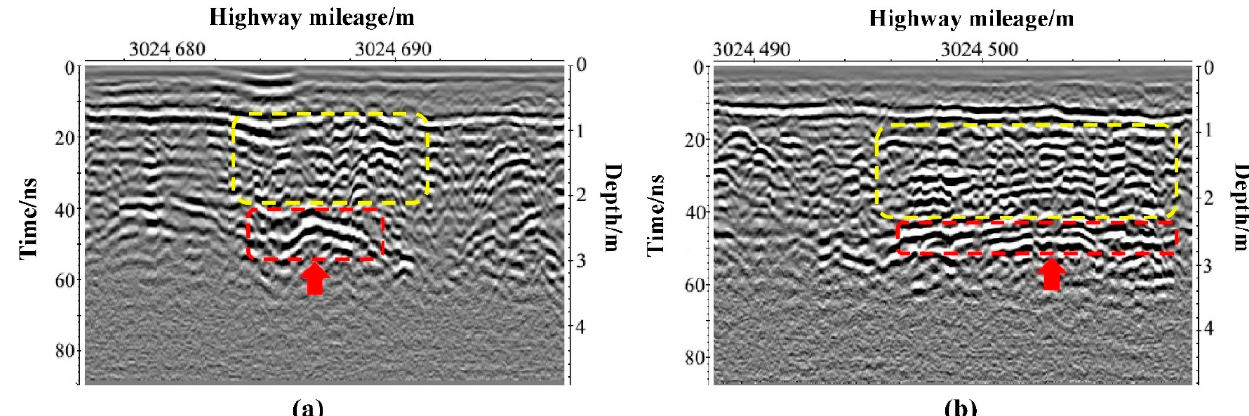
Figure 9. GPR images indicating looseness of the block-stone layers: ( a ) K3024 + 676 to K3024 + 697; ( b ) K3024 + 488 to K3024 + 509. The yellow dashed box shows the abnormal area of the block-stone layer, the red dashed box shows the abnormal area of the ground, and the yellow and red arrow is used to facilitate reading .